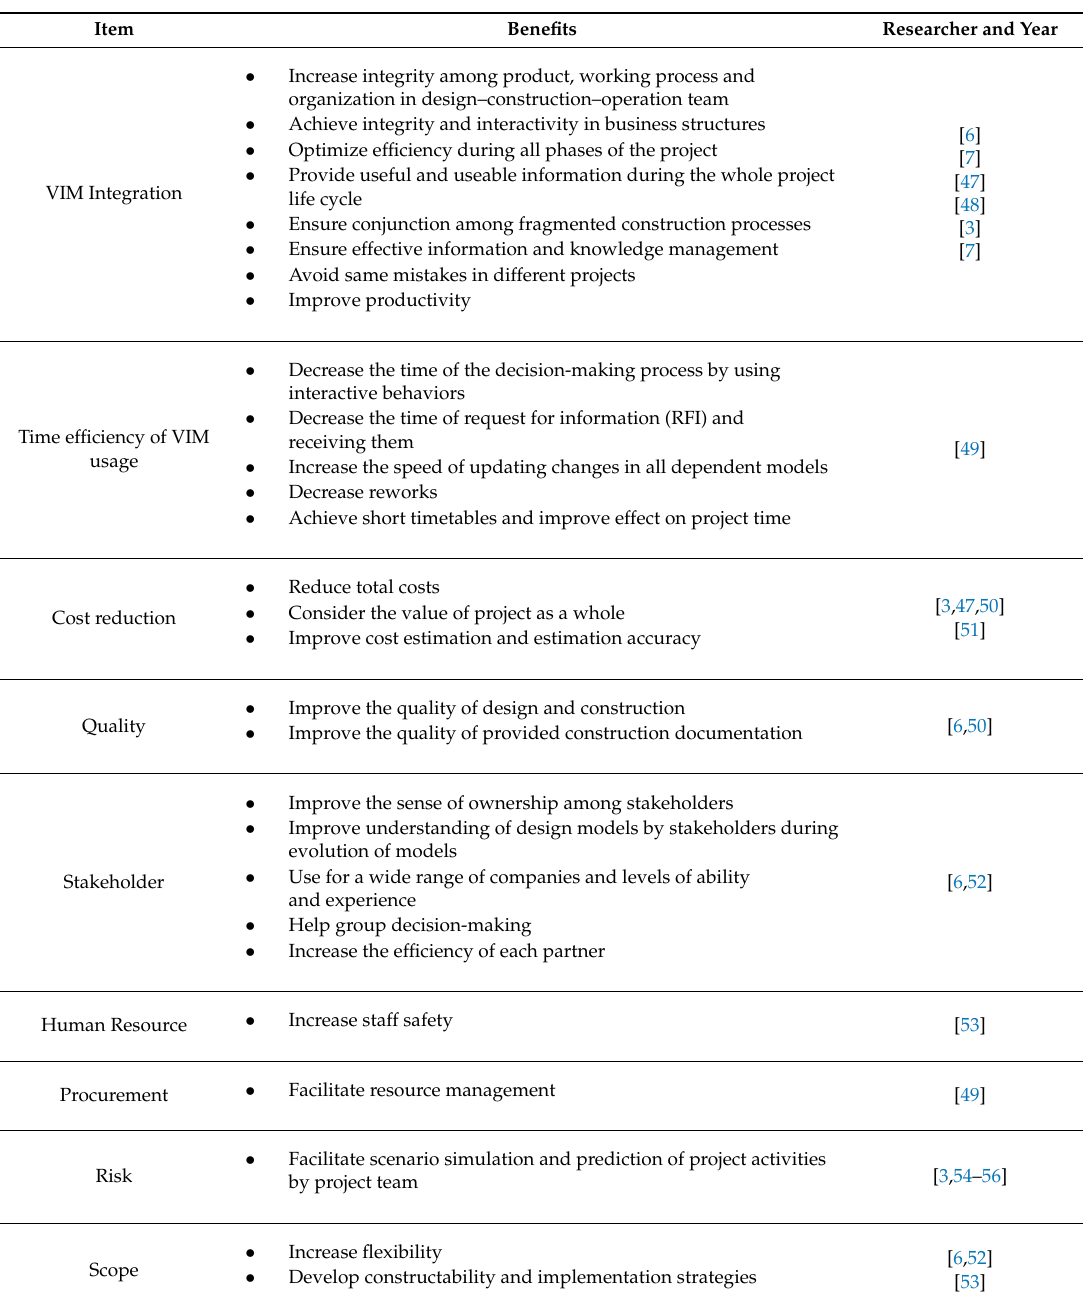
Table 1. Benefits of VIM